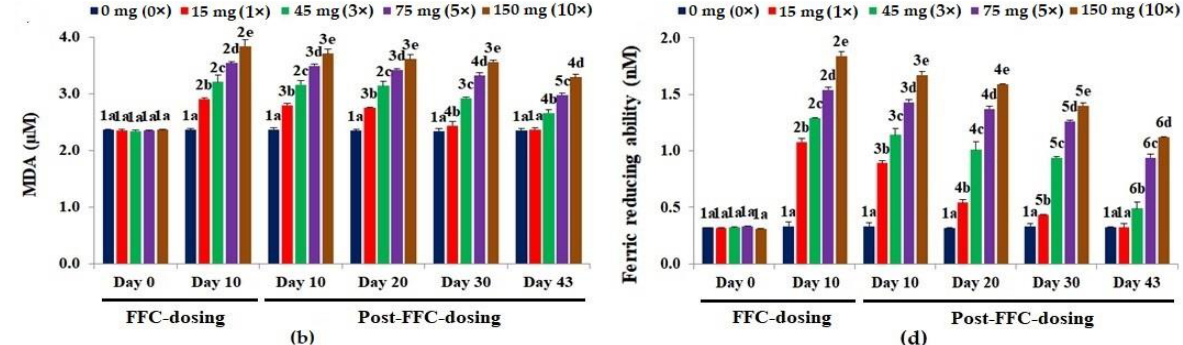
Figure 3. Malondialdehyde [MDA] levels in the ( a ) liver and ( b ) kidney tissues and ferric reducing antioxidant potential [FRAP] in the ( c ) liver and ( d ) kidney tissues of Oreochromis niloticus juveniles after dietary florfenicol (FFC) administration at 1–10 times the therapeutic dose of 15 mg kg biomass − 1 day − 1 for 10 consecutive days. a–e: Bars of a particular day showing common alphabets differed insignificantly ( p > 0.05). 1–6: Bars of a particular treatment (dose) showing common numerals differed insignificantly ( p > 0.05).